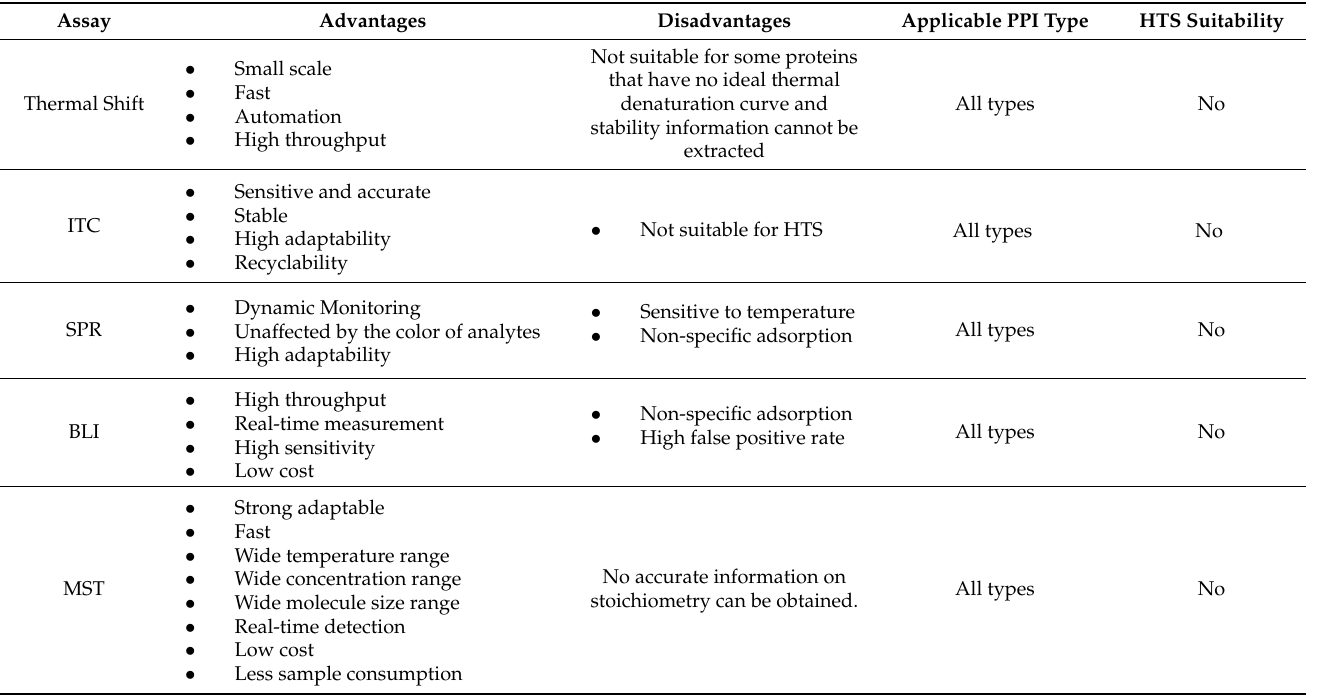
Table 2. Comparison of affinity-based